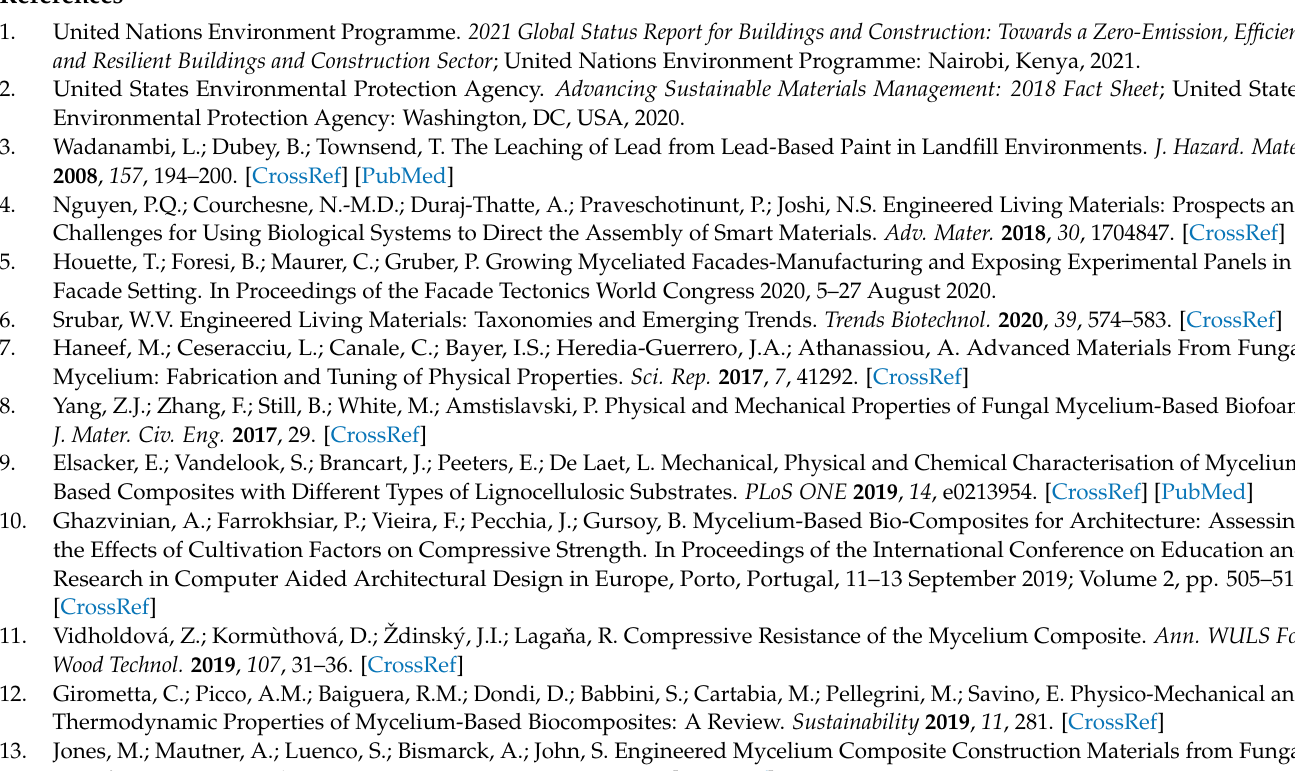
Specimens with less than 10% contamination